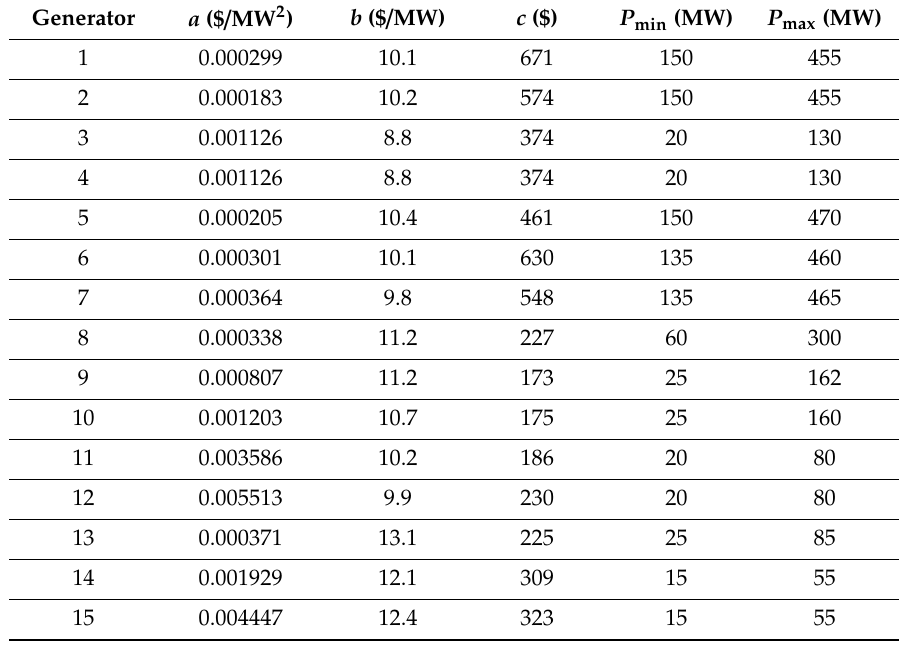
Table 7. 15-unit system cost coe ffi cients with lower and upper power limits.